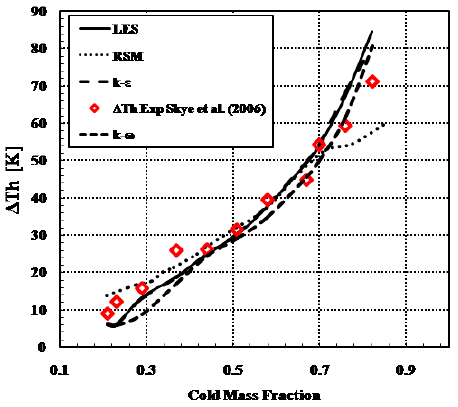
Fig. 15. Variation of the hot exhaust temperature difference for different types of operating turbulence models as a function of cold flow fraction (compared with the experimental results)